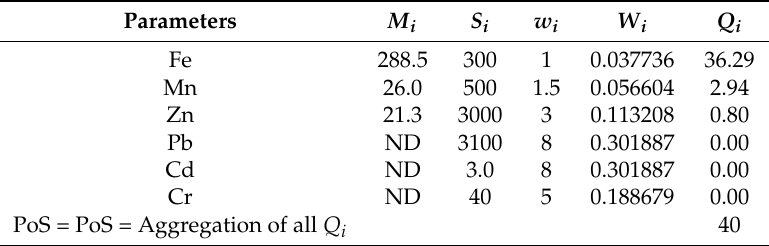
Table 6. The PoS calculation for groundwater samples (GW01 as an example) of the study area. Parameters